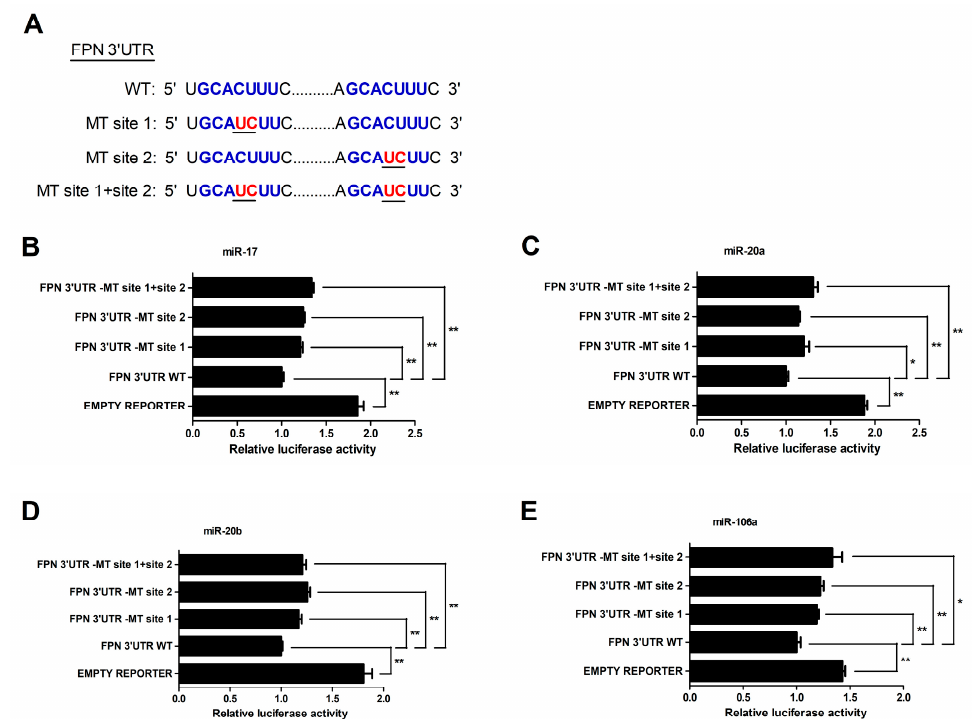
Figure 3. MiR-17, miR-20a, miR-20b, and miR-106a directly bind the 3 ′ UTR of FPN in HCT116 cells. ( A ) Schematic illustration of FPN 3 ′ UTR WT and FPN 3 ′ UTR-MT sequences were cloned downstream of a luciferase reporter. ( B – E ) The relative luciferase activity of FPN 3 ′ UTR-MT site 1, FPN 3 ′ UTR-MT site 2, FPN 3 ′ UTR-MT site 1+site 2 and empty luciferase reporter compared to FPN 3 ′ UTR WT. Values were expressed as means ± SEM, n = 4 in each group, * p < 0.05, ** p < 0.01.